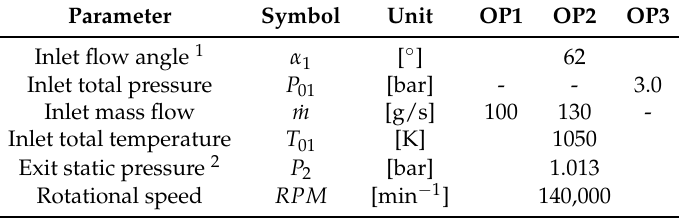
Figure 2. Performance map of the baseline turbine wheel. Table 1. Definition of boundary conditions shown in Figure